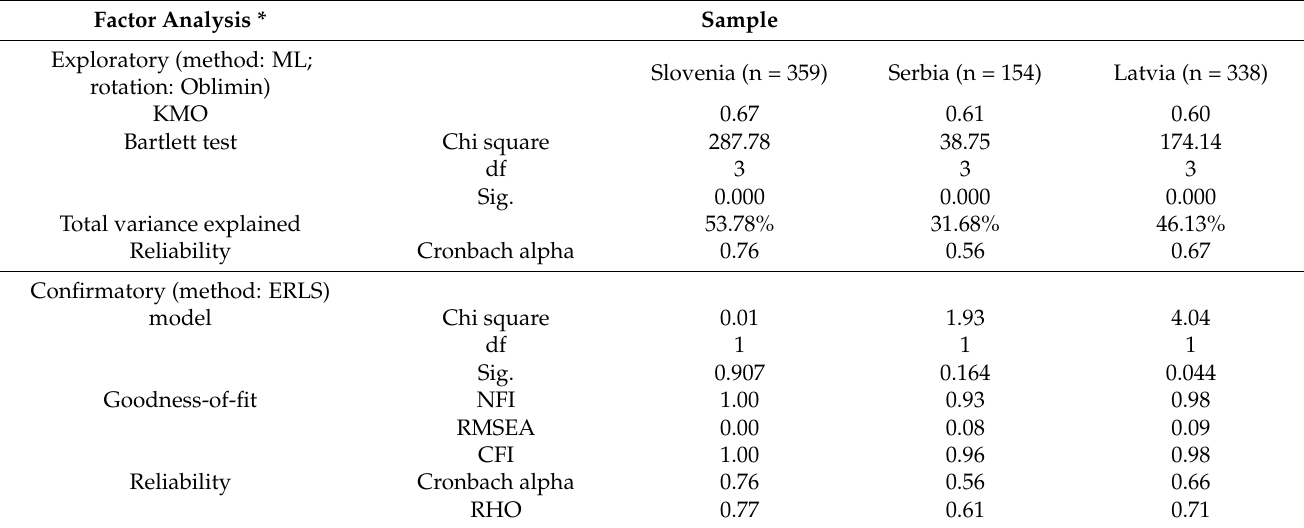
Table 2. The innovativeness of the entrepreneur construct—factor analysis and reliability